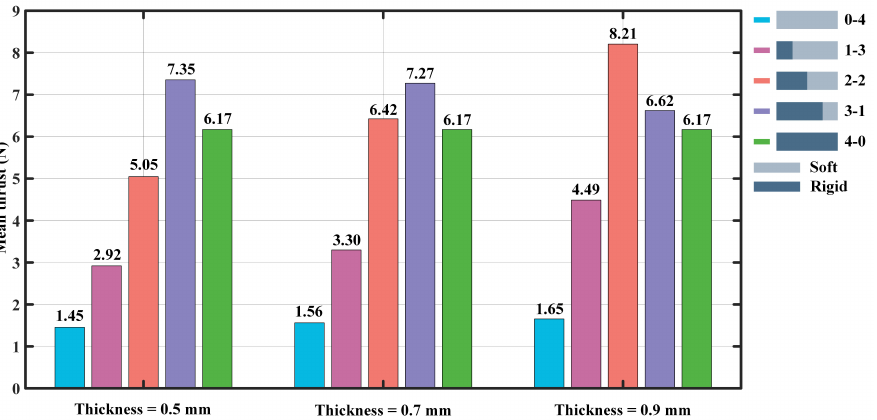
Figure 8. The mean thrust produced by the foil at the flapping frequency of 1.5 Hz, averaged over all flapping angles from 20° to 50°.